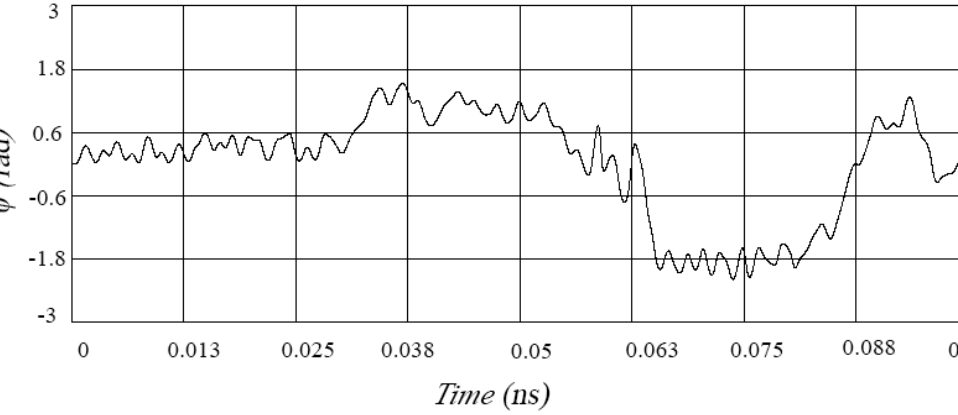
Figure 6. Angle of fullerene precession which determines rotation of instantaneous axis of rotation in plane perpendicular to vertical axis of fixed coordinate system.